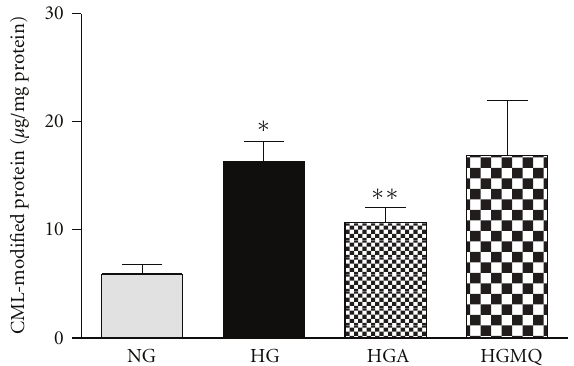
Figure 5: Chronic exposure to high glucose induces apoptosis in BRP. Subconfluent cells in 3 cm dishes were exposed to normal (NG, 5.6mM) and high (HG, 25mM) glucose in the absence (NG, HG) and presence of 500 μ M apocynin (NGA, HGA) or 1 μ M MitoQ (NGMQ and HGMQ). After 4 days, the cells were washed twice with ice-cold PBS, lysed and apoptosis was measured using colorimetric caspase-3 activity. Data are represented as Means ± SEM of 3–6 separate experiments. ∗ P < . 05 versus NG, ∗∗ P < . 05 versus HG.